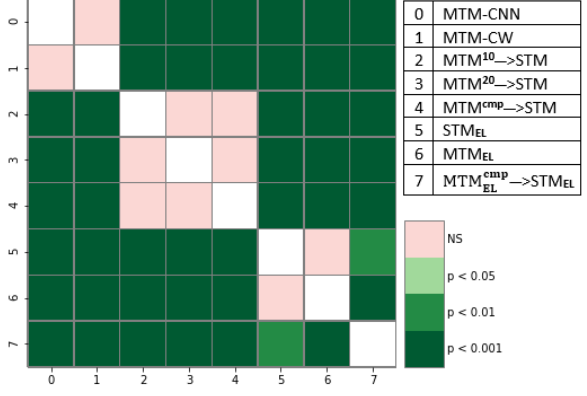
Figure 13. Post hoc Friedman test comparison of ELMo.